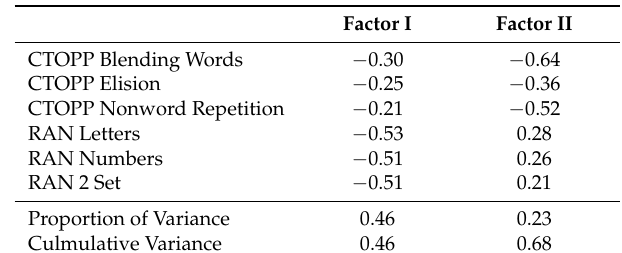
Table 6. Principal component analysis (PCA) of reading subtests. The factors and factor loadings of the PCA computed over the standard scores of the Comprehensive Test of Phonological Processing (CTOPP) and Rapid Automatized Naming (RAN) subtests. The PCA yielded two factors that explained 68% of the total variance in standardized test scores. Factor 1 had negative loadings for the both the CTOPP and RAN subtests, albeit much stronger loadings for the RAN scores, suggesting this factor reflects primarily rapid-naming skills. Factor 2 produced moderately sized negative loadings for the CTOPP tests and smaller positive loadings from the RAN tests, suggesting that this factor largely reflects phonological-awareness skills.